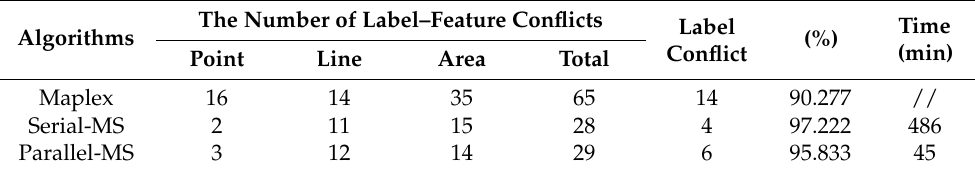
Table 6. Comparison of the proposed algorithm with Maplex Label Engine on the third dataset.